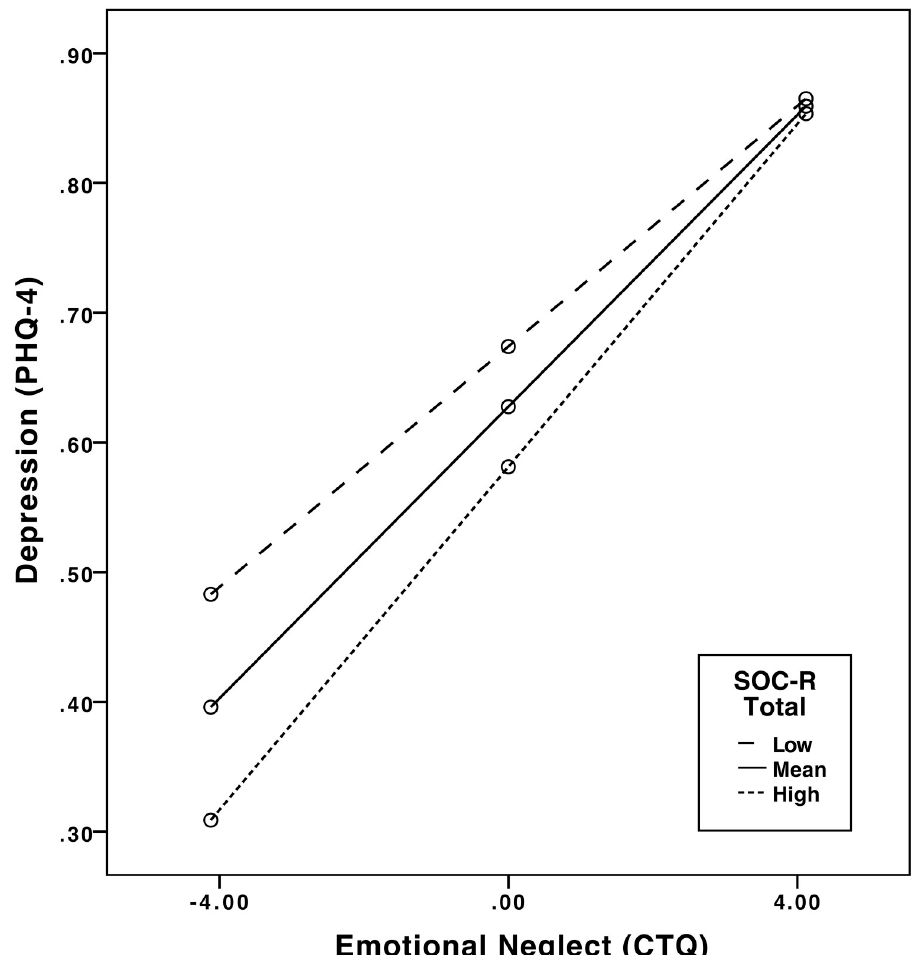
Fig 3. Plot of the regression of emotional neglect on depression at different levels of the moderator (SOC-R). Note: High and low levels refer to one standard deviation above and below the mean value of the moderator (i.e.